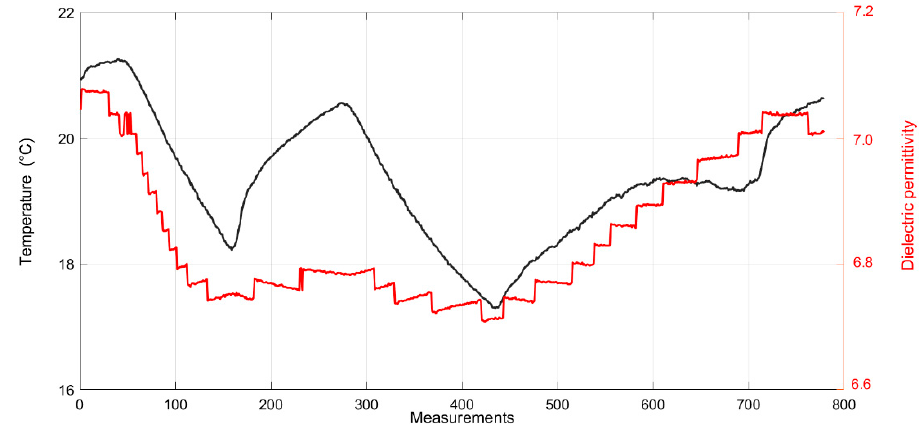
Figure 10. Relative dielectric permittivity (red) and temperature (black) measured in a mixture of sandy grain, diesel oil, water and gas (measurements performed with a Water Content Probe). The measures refer to a time-window of 24 h.